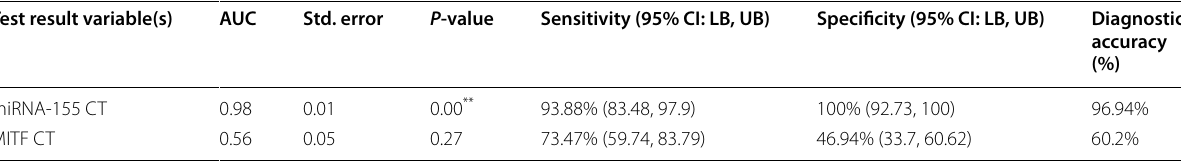
AUC area under the curve, CI confidence interval, LB, UB lower bound, upper bound ** P value 0.01, statistically significant ≤